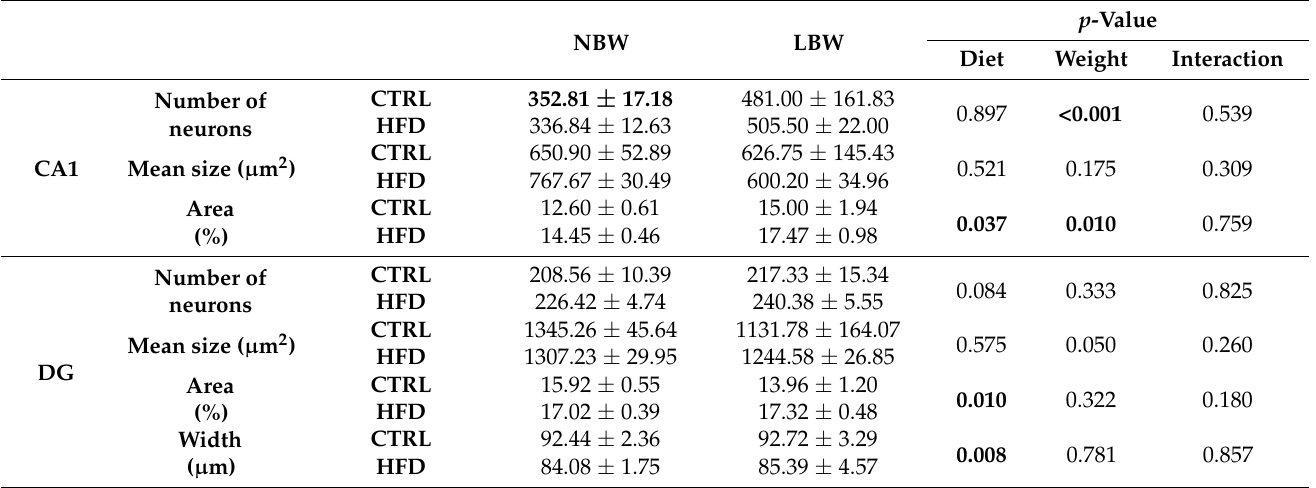
Table 2. Effect of HFD on NeuN immunostaining in the hippocampus of one year-old pigs born with normal birth weight (NBW) or low birth weight as result of IUGR (LBW) and fed a control diet (Ctrl) or an HFD diet. p -Value NBW LBW Diet Weight Interaction